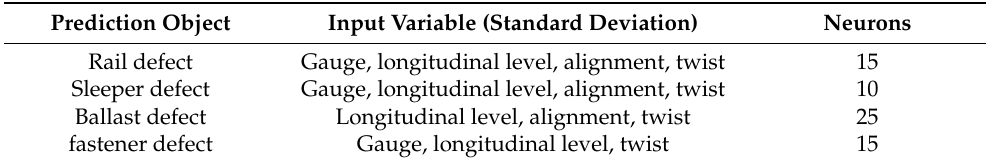
Table 4. Settings for ANN model in [88]. Adapted from